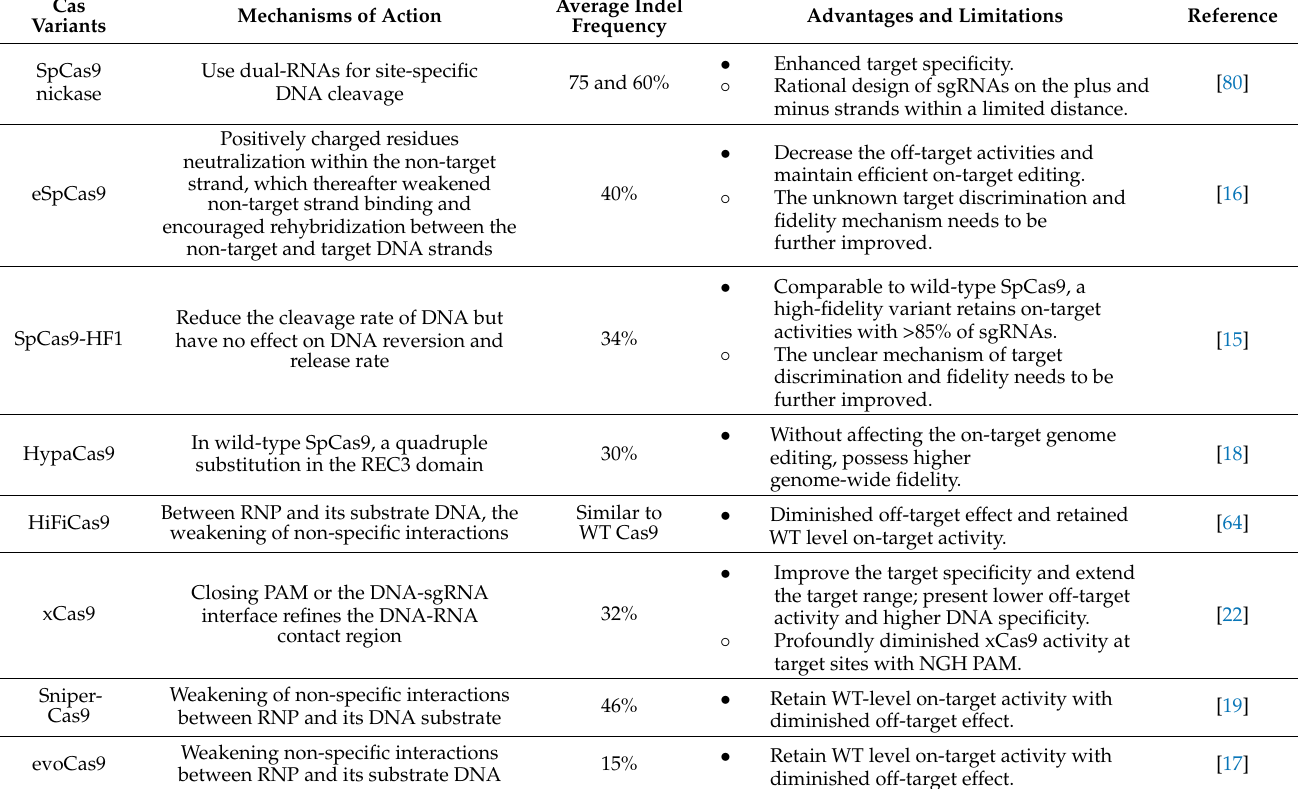
Table 2. Different Cas9 variants and their salient